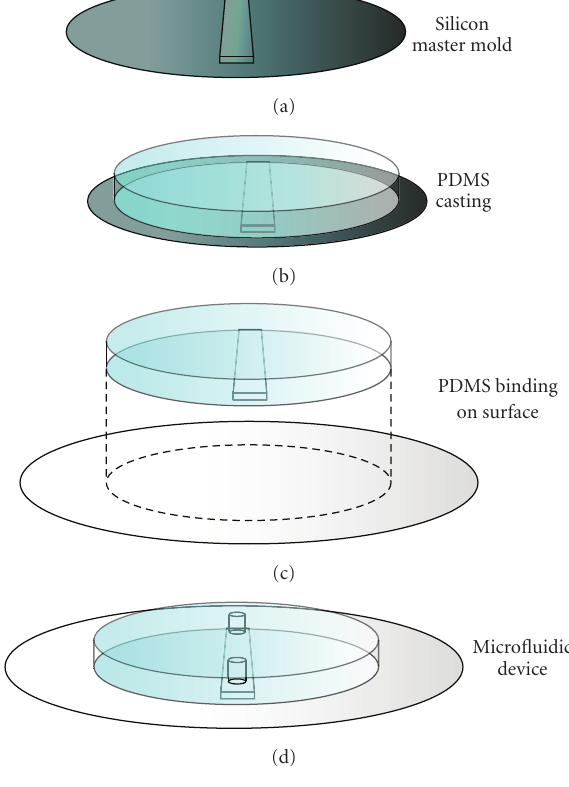
Figure 3: Schematic overview of the fabrication of PDMS chips. (a) The process starts by fabricating a silicon master mold— with typical dimensions of 10 centimeter in diameter and 0.5 millimeter thickness—with microfluidic structures on top. (b) A viscous mixture of PDMS oligomers and crosslinker is poured on top of the mold and allowed to form a flexible, crosslinked network. (c) The slab of PDMS is peeled o ff of the mold and bound to a glass or PDMS surface to produce closed microfluidic channels. (d) The microfluidic device is ready to be used. Prior to binding to the surface, holes can be punched in the slab of PDMS to reach the resulting microfluidic